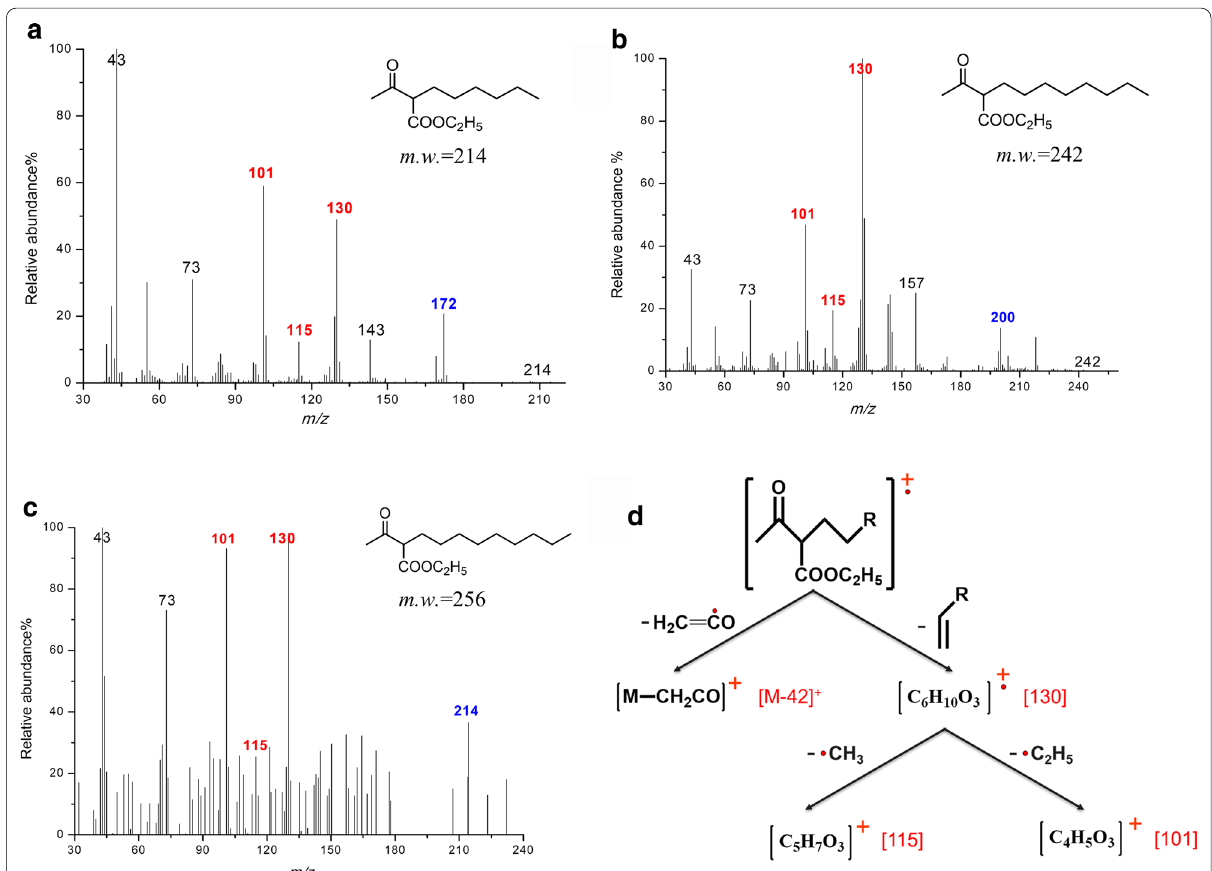
Fig. 3 2‑Acetylalkanoic acids as a signature metabolic intermediate in anaerobic alkane hydroxylation. Fragment ions at m/z 130, 115, 101 are shown in red, [M‑42] is shown in blue. a , 2‑Acetylnonic acid detected in H88‑21; b , 2‑Acetyl undecanoic acid detected in Z3‑25; c ,